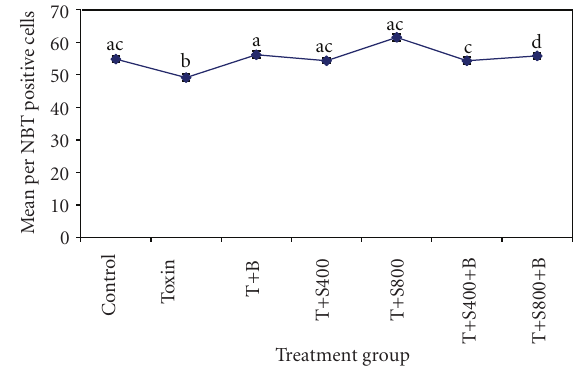
Figure 1: E ff ect of dietary supplementation of seabuckthorn berries (SBT) and glucomannan (GM, mycotoxin binder) on macrophage function test (per cent NBT positive cell) in T-2 toxin-fed birds. Figure 2: E ff ect of dietary supplementation of seabuckthorn berries